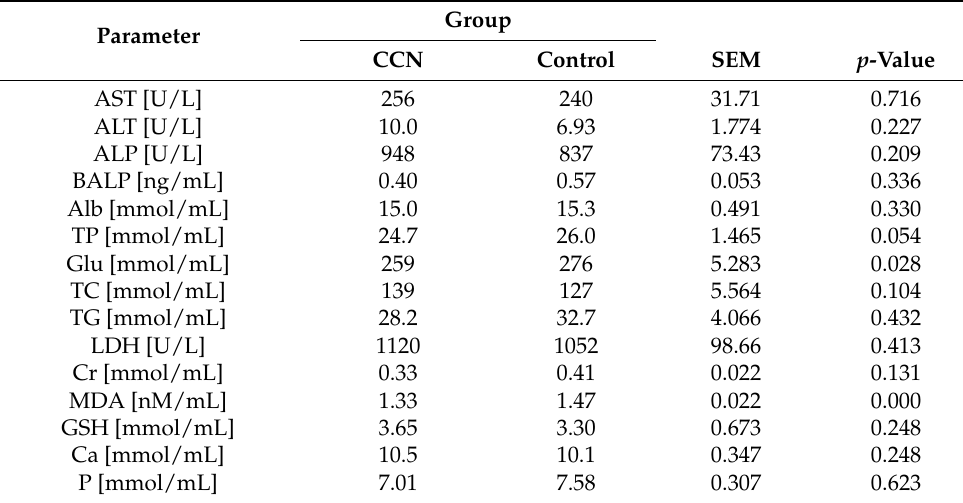
Table 2. Serum parameters of chicken embryos.